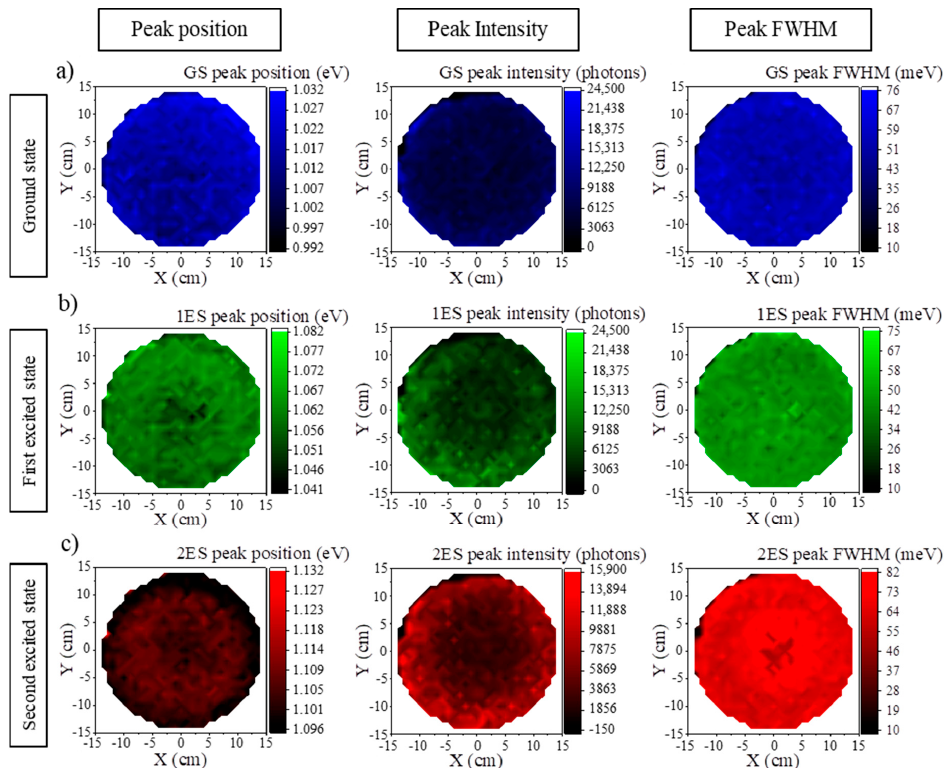
Figure 8. Room temperature µ PL 300 mm mapping of the energy, intensity, and FWHM for three stacked InAs QDs grown on GaAs/Ge/Si (001) structure for: ( a ) GS peak; ( b ) 1ES peak; and ( c ) 2ES peak. Spectra are acquired at 673 different positions to map entirely the Si 300 mm wafer.